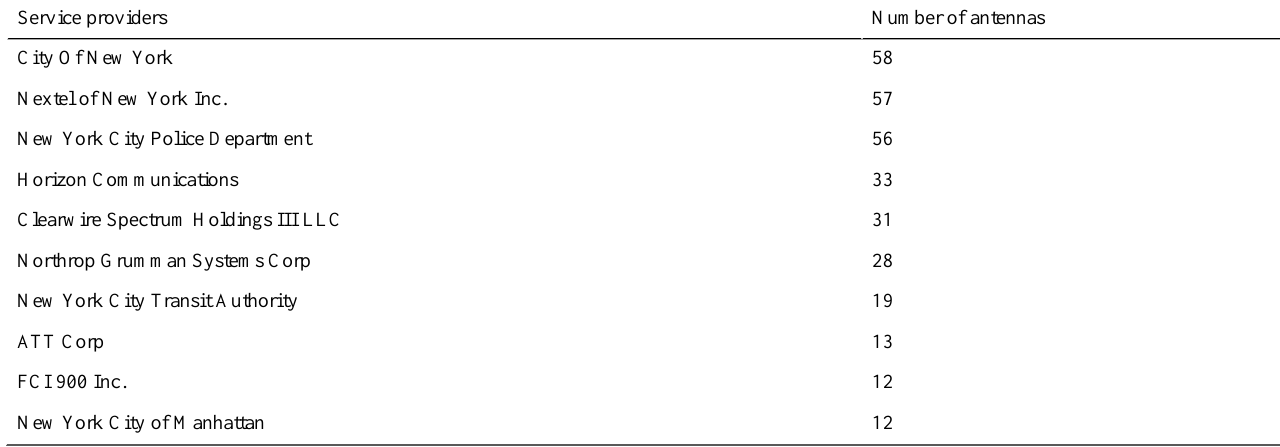
Table 2. Service providers and antennas in the study